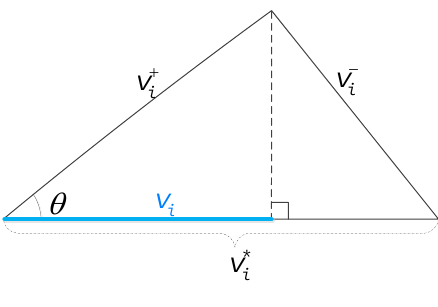
Figure 3. Prospect projection of